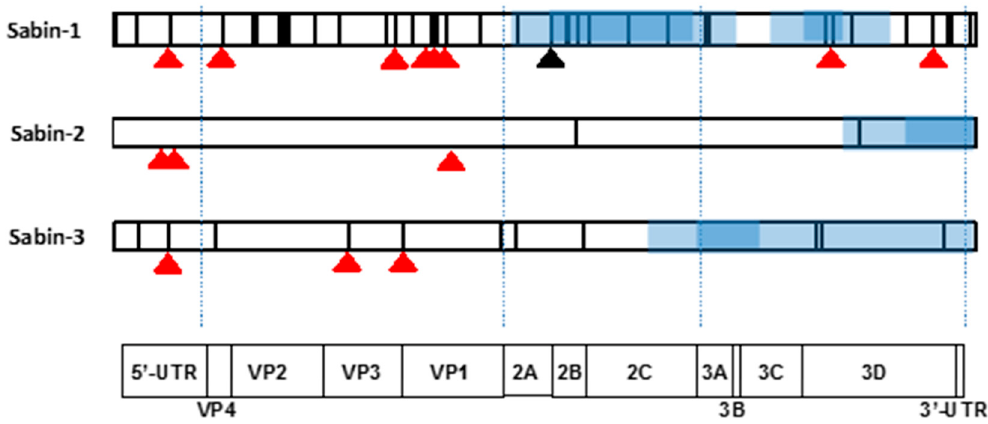
Figure 3. Location of known attenuating mutations (red triangles), an often-reverted serotype-1-specific mutation (black triangle) and mutations acquired upon the derivation of vaccine strains (vertical lines) in the genomes of Sabin viruses. Regions speculated to determine a decreased fitness are highlighted as blue rectangles. Their darker and lighter shading refer to the proposed “weak” and “provisionally weak” genomic areas (see Figure 1). The schematic representation of poliovirus genome and its functional elements are given at the bottom.